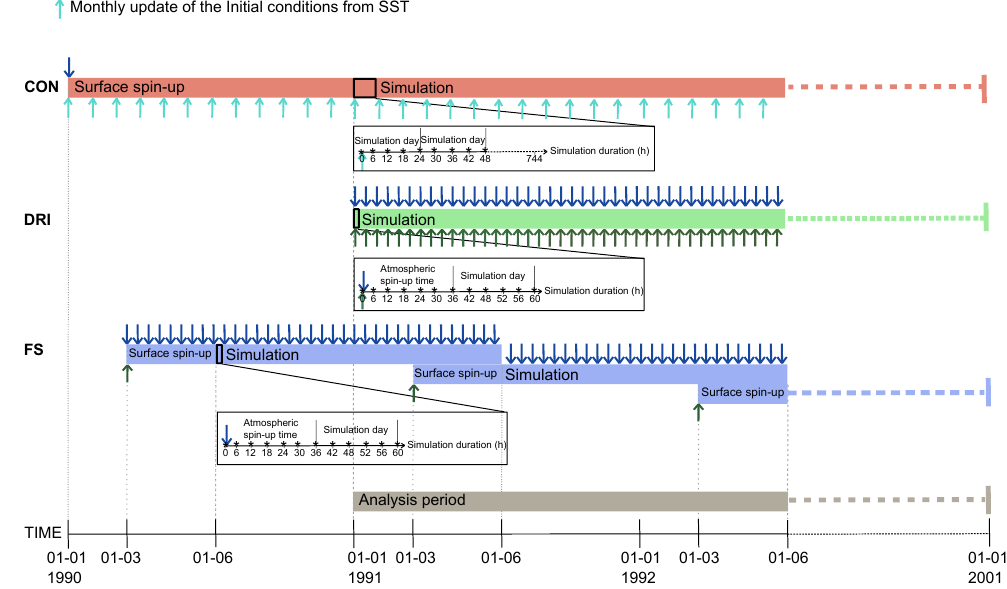
Figure 2. The set-up of the three downscaling approaches CON, DRI and FS used in this study. It represents the spin-up time for the different simulations, the analysis period of the total experiment and the update frequency of the lateral and initial boundary